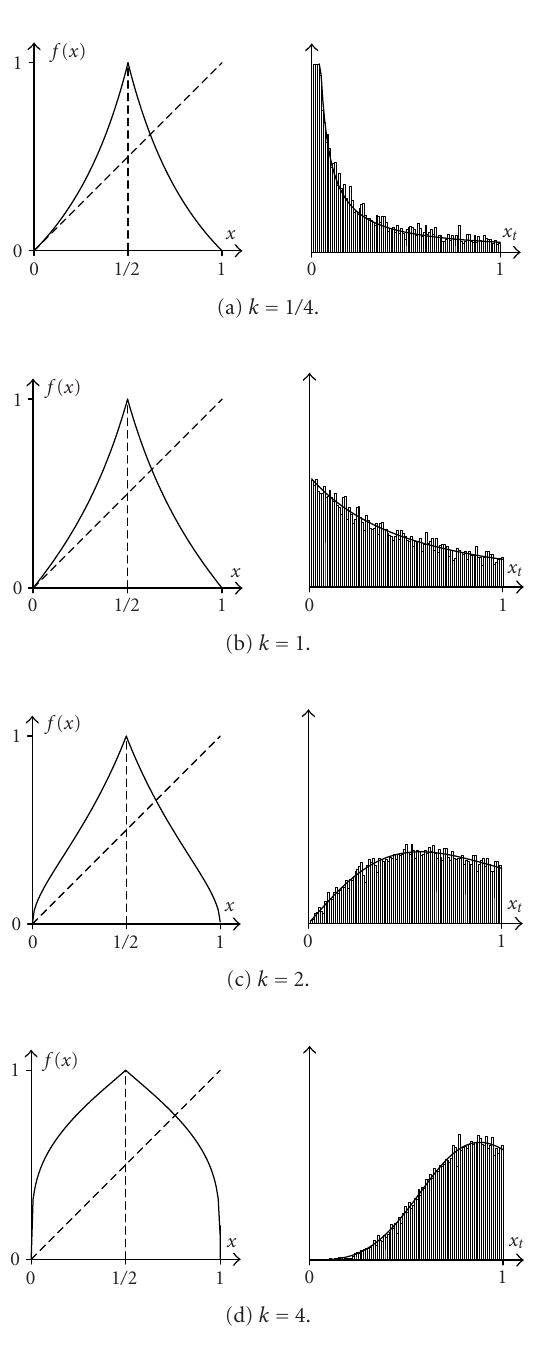
Figure 4.1. f L ( x ) = (( x k (1 − x ) k +3 x k − (1 − x ) k +1) / ( x k (1 − x ) k +3(1 − x ) k − x k +1)) 1 /k , k >